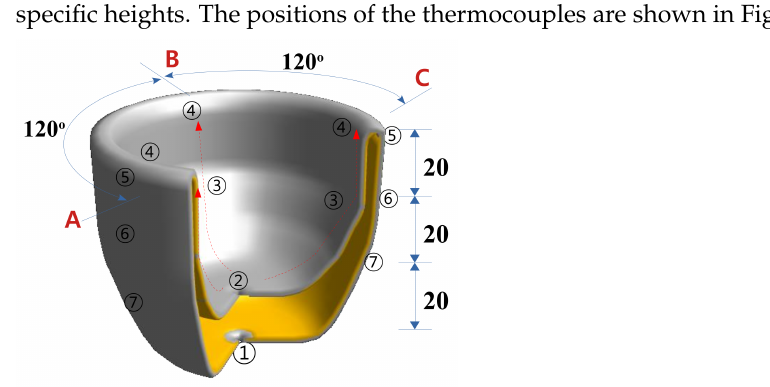
Figure 5. Thermocouple positions and A, B, C measuring lines with 120 ◦